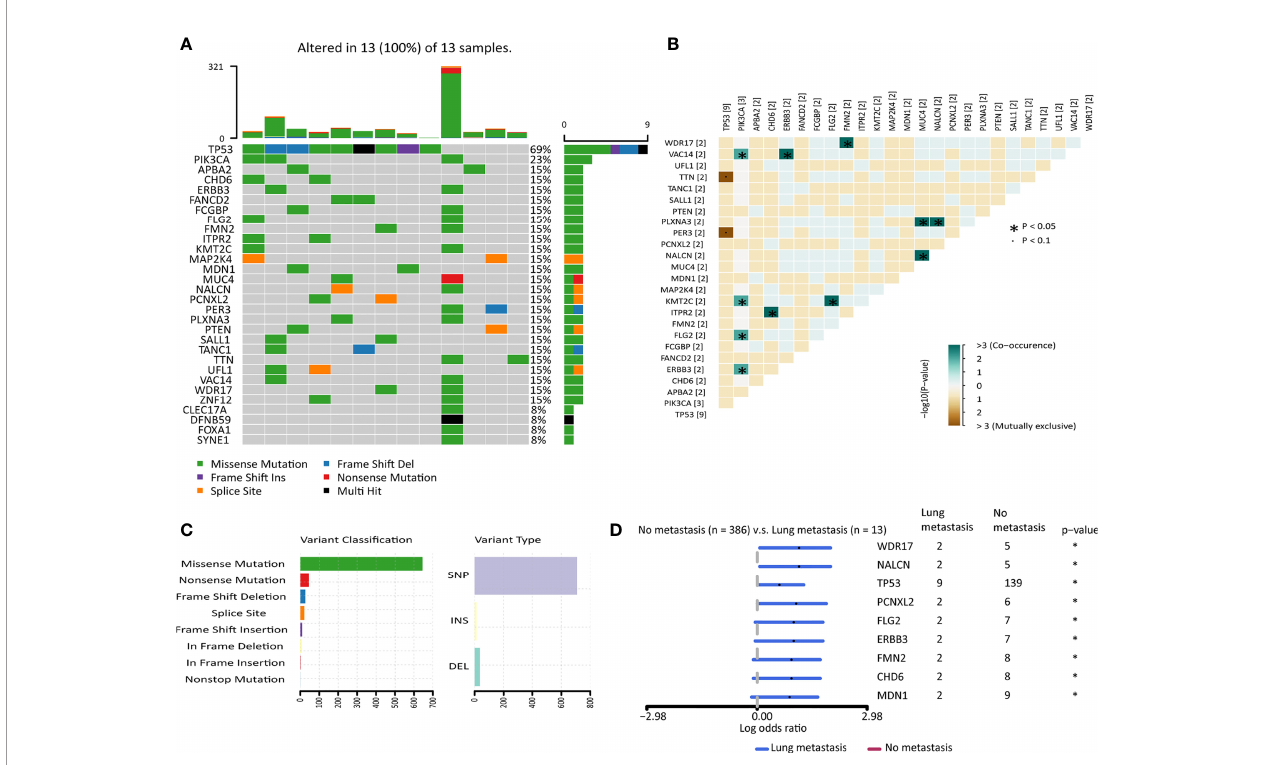
FIGURE 2 | The mutation landscape of breast cancer patients with lung metastasis in the TCGA cohort. (A) Color-coded matrix of the top 30 most frequently mutated genes in breast cancer patients with lung metastasis (n=13). (B) Matrix of mutually exclusive or co-occuring mutational events. (C) Bar charts of variants classi fi cation and type. (D) Forest plot with x-axis as log10 converted odds ratio and differentially mutated genes between the no metastasis group and the lung metastasis group on the y-axis. *: p <